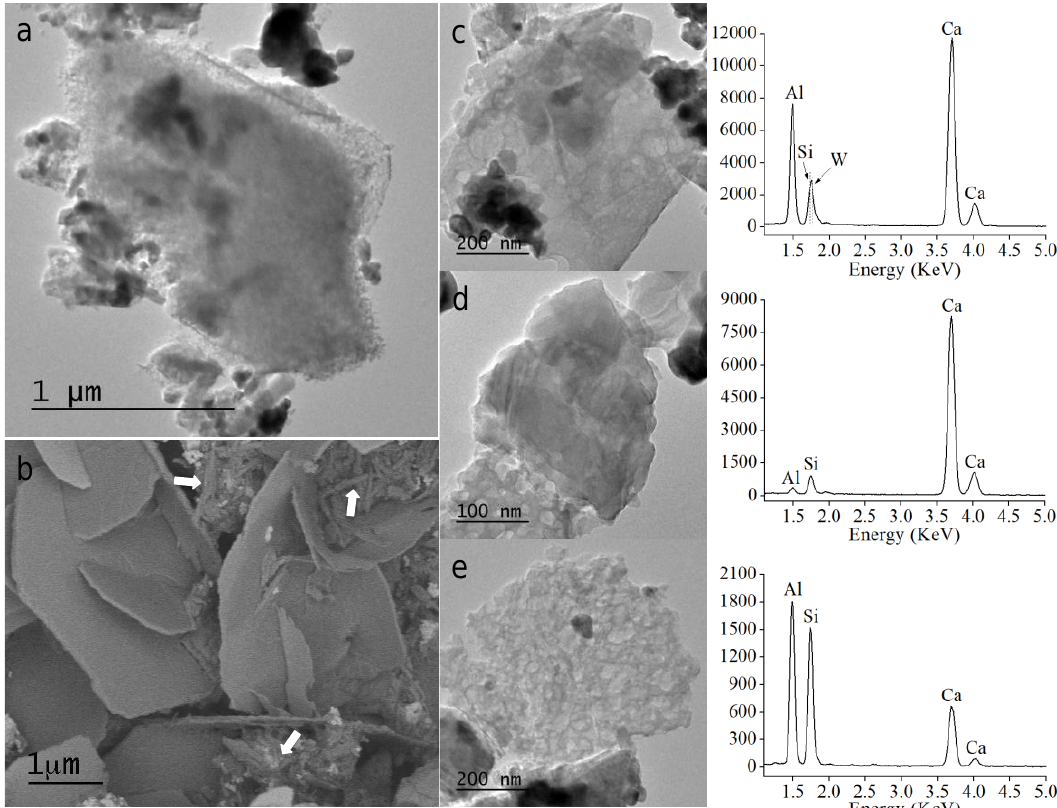
Figure 4. Electron microscopy study of hydrated MTA Repair HP material after 24 h setting: ( a ) TEM and, ( b ) FEG-SEM general view micrographs. White arrows indicate sub-micron needle-like particles; ( c – e ) high magnification images showing sample characteristic areas and corresponding EDX analysis (column at the right). The y-axis values of EDX plots correspond to acquired energy counts.